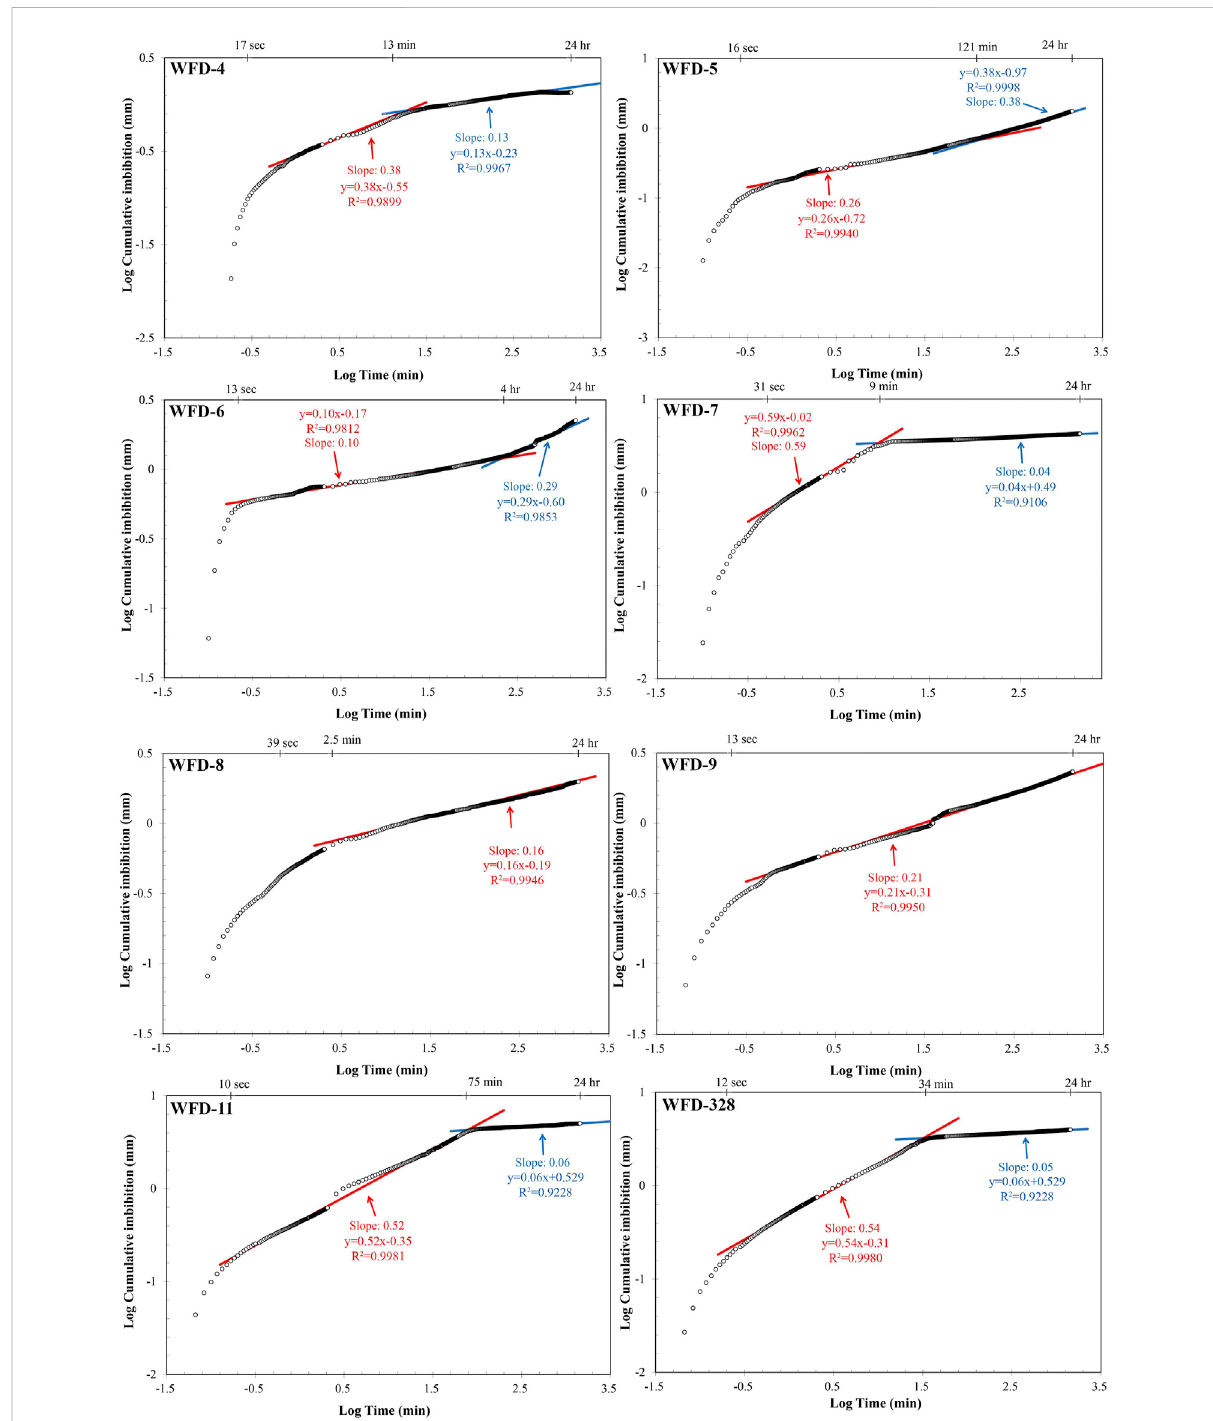
FIGURE 7 Plots of imbibition time vs. cumulative imbibition volume of SI results with fi tted imbibition